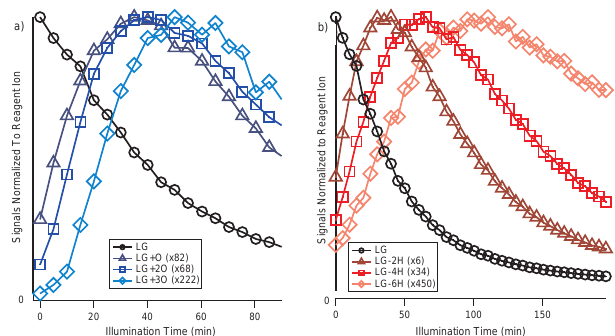
Figure 2. The evolution of the “ + O” (a) and the “ − 2H” (b) series from levoglucosan (LG). The signal of each compound normalized by the reagent ion intensity at m/z 145 (I ( H 2 O ) − ) is shown as a function of the irradiation time. The signals are multiplied by the bracketed number to be on